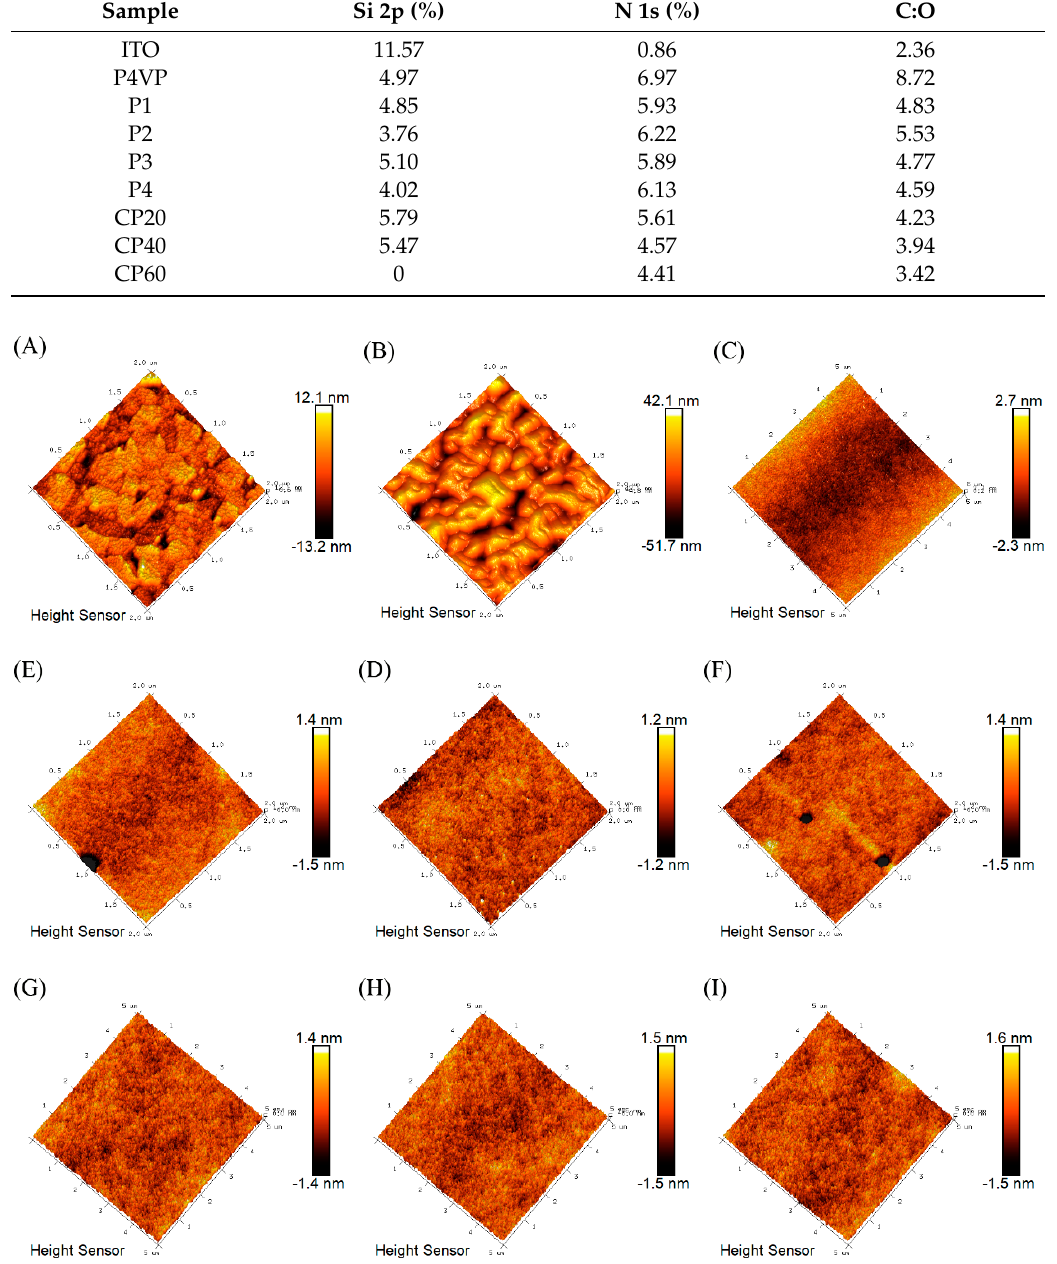
Table 2. XPS-analysis of surface atomic concentrations and molar ratios of bare and polymer-modified ITO surfaces.